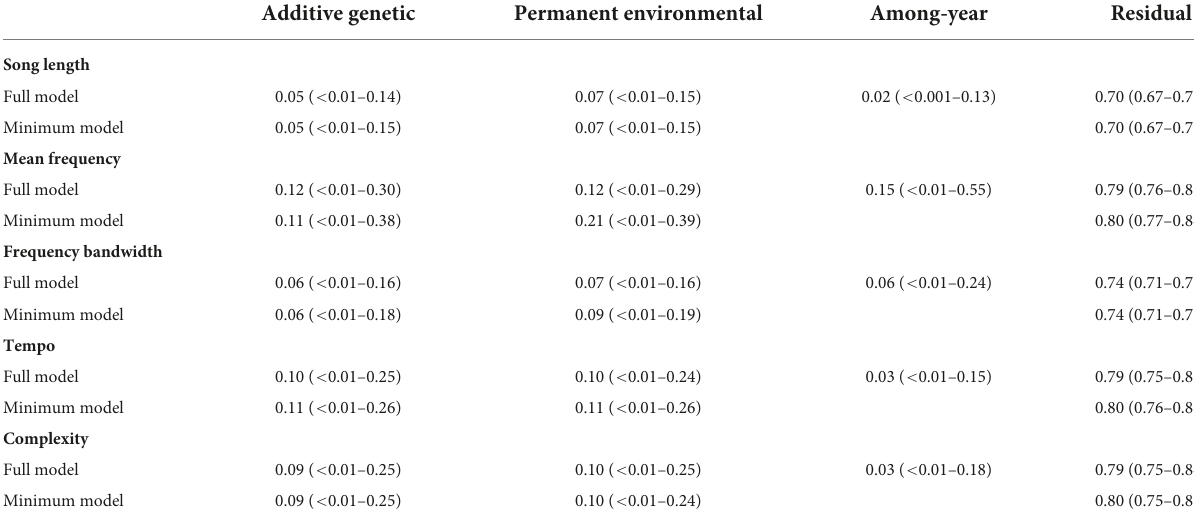
TABLE 2 Variance estimates of random effects with 95% credible intervals from the animal models for each song